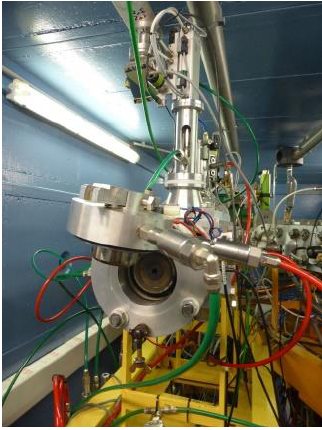
Figure 2. Targetry “hatch tip” low current (<2 µA) for development.